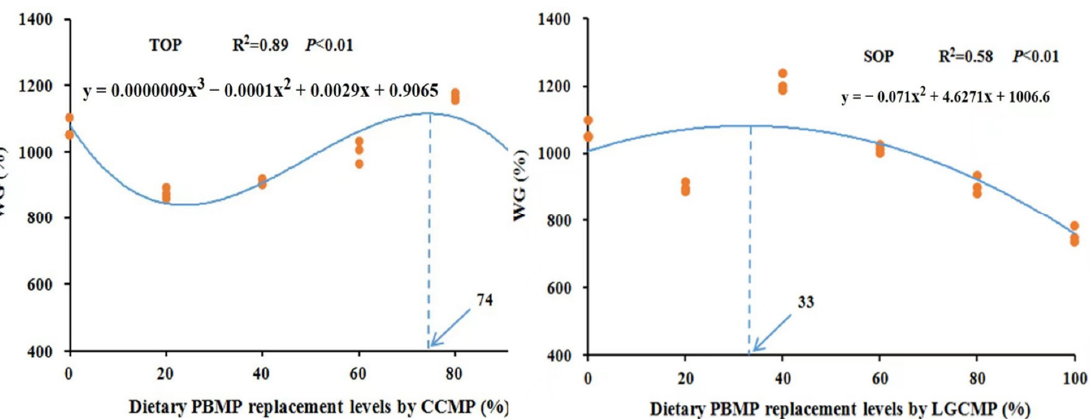
Figure 1. Relationship of WG% of hybrid grouper juveniles with different dietary PBMP replacement levels by CCMP or LGCMP.